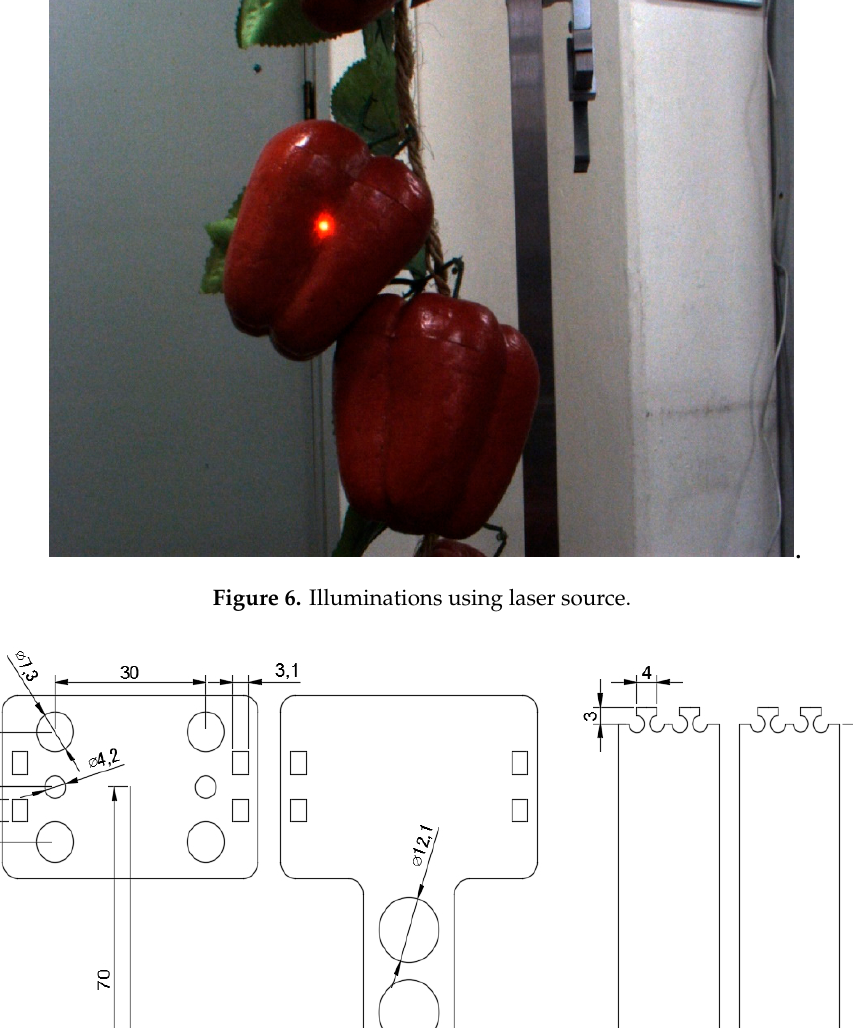
Figure 7. A design of joint parts for laser sources.